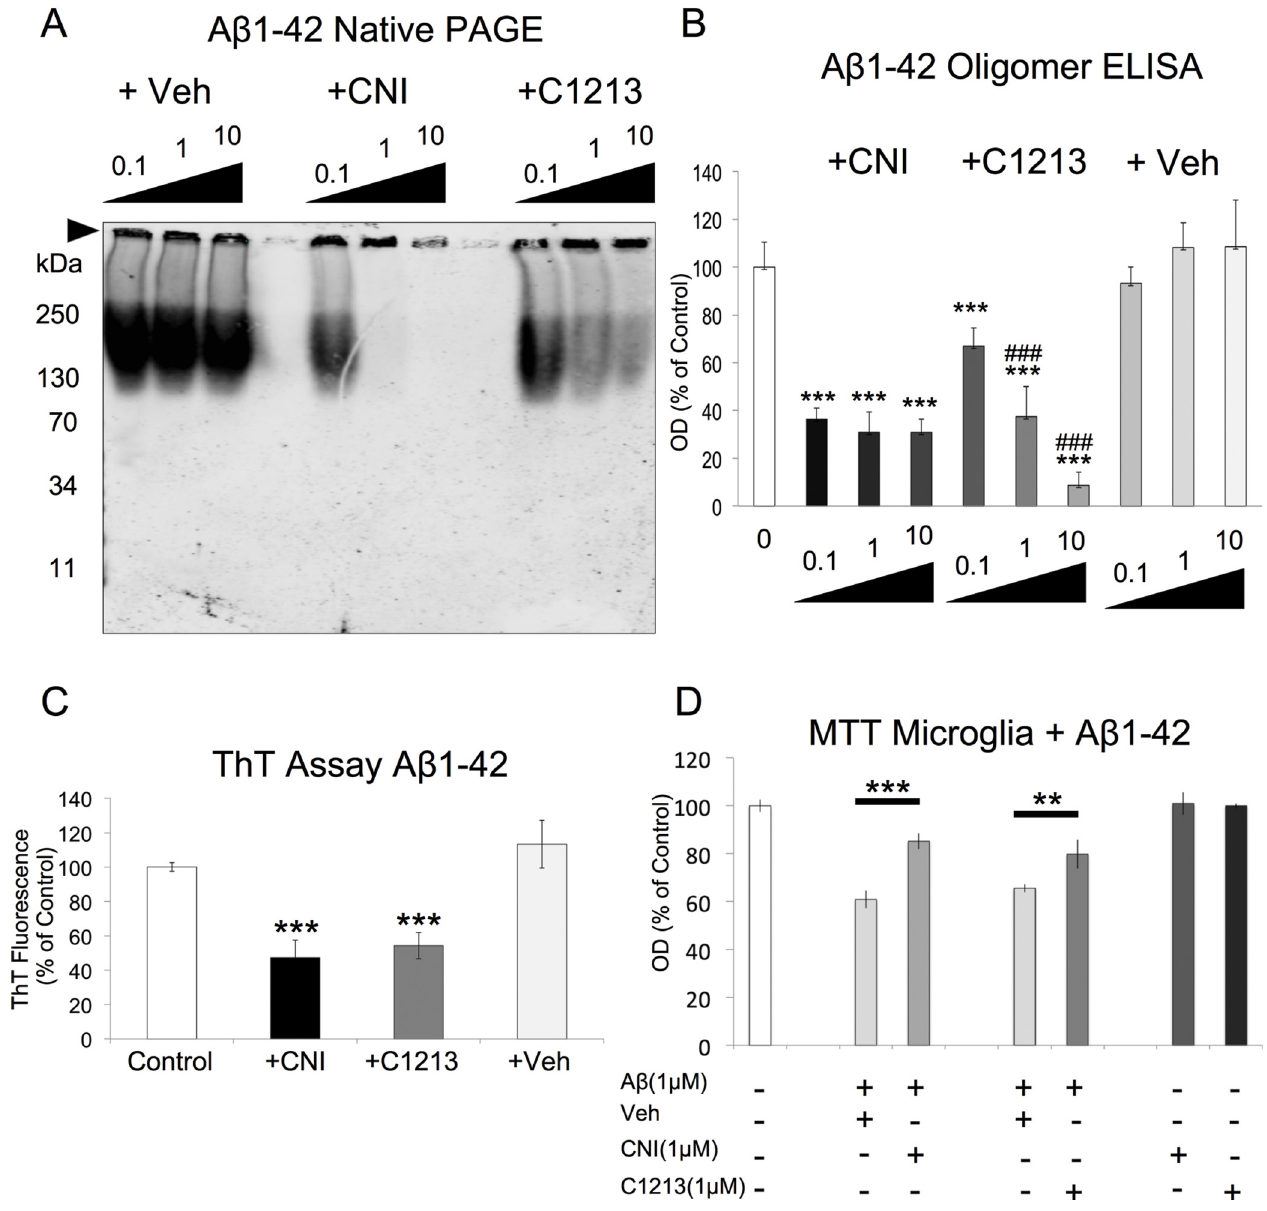
Figure 4. C1213 and CNI-1493 change A β 1-42 aggregation in vitro . Soluble A β 1-42 aggregates were incubated for 3 h with